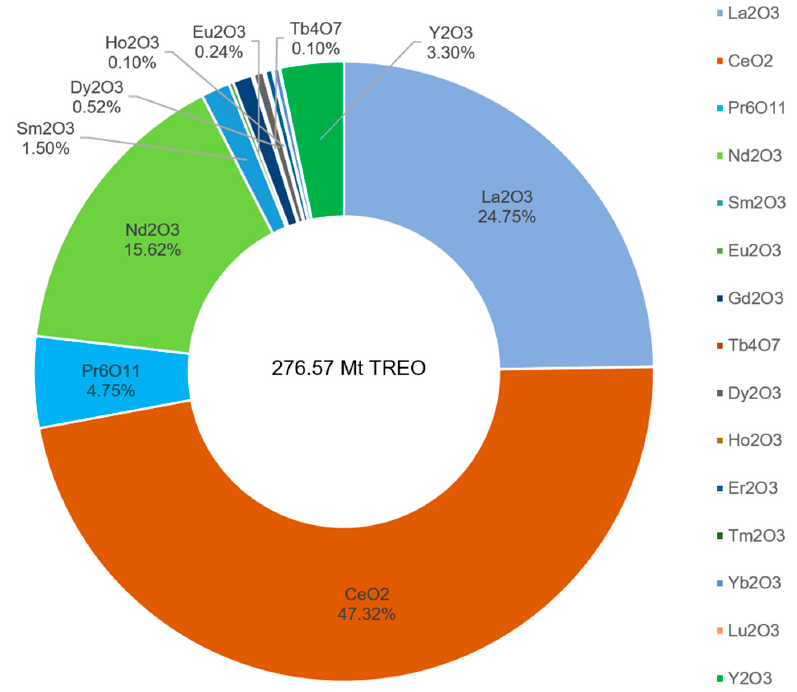
Figure 6. Code-compliant rare earth resources for 59 advanced-stage REE deposits (as of January 2017).